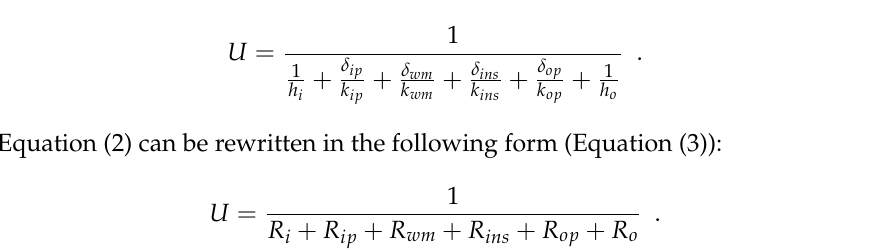
Conductivity (W/mK)